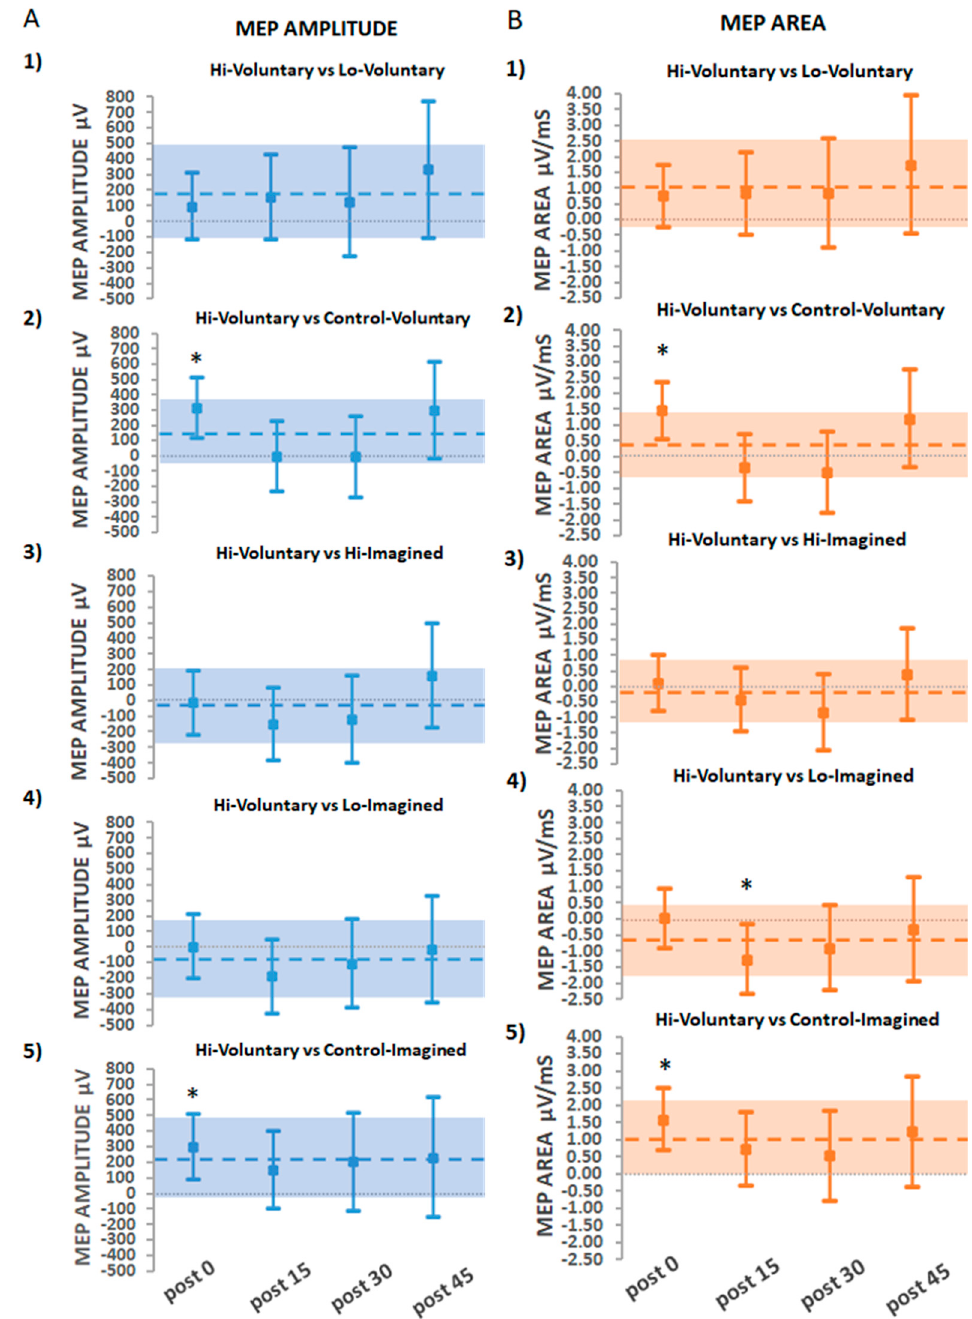
Figure 5. Estimated adjusted effect differences in absolute units between Hi-Voluntary and each intervention on ( A ) MEP amplitude and ( B ) MEP area, at each post-intervention time point and averaged over time. Error bars depict 95% CIs. Dashed lines depict estimates averaged over time with a shaded bar for 95% CIs; * indicates significant effects ( p < 0.05).